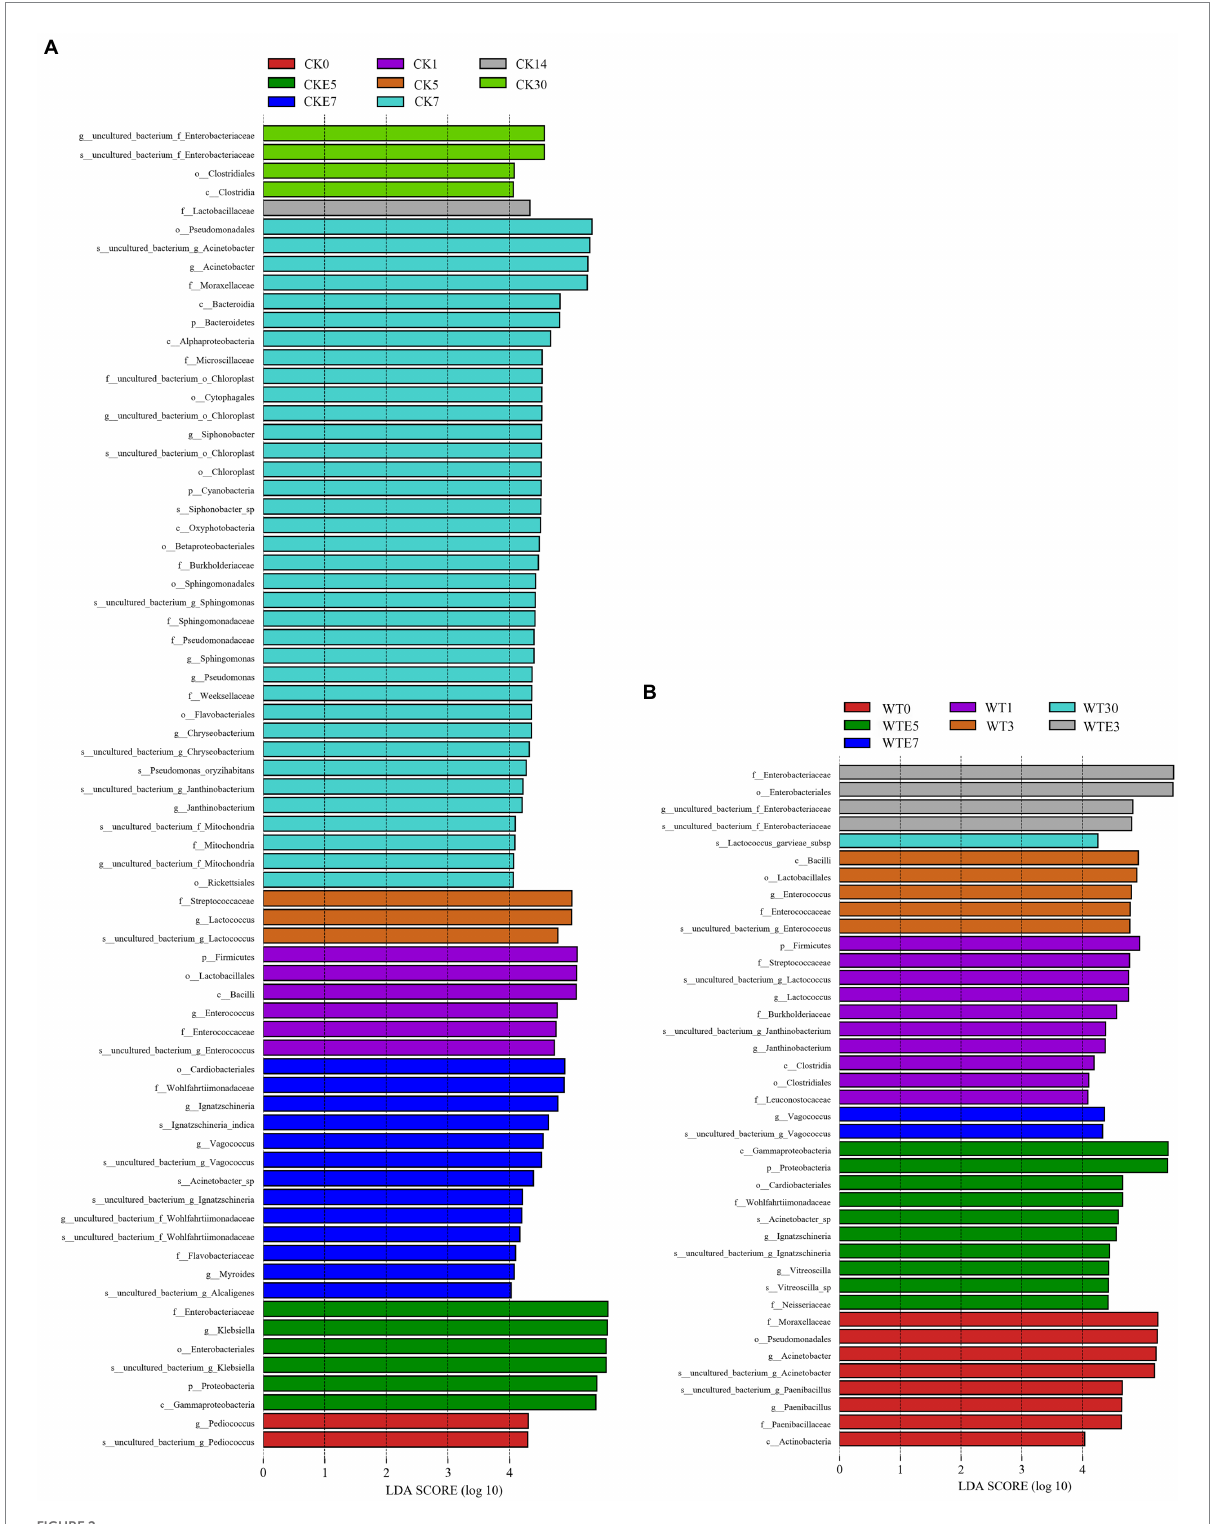
FIGURE 2 Comparison of bacterial changes during ensiling and aerobic exposure using LEfSe analysis. ( A , CK group; B , WT group; CK, unwilted silage; CKE, unwilted silage aerobic exposure; WT, Wilting silage; WTE, Wilting silage aerobic exposure; Arabic numerals indicate the time of